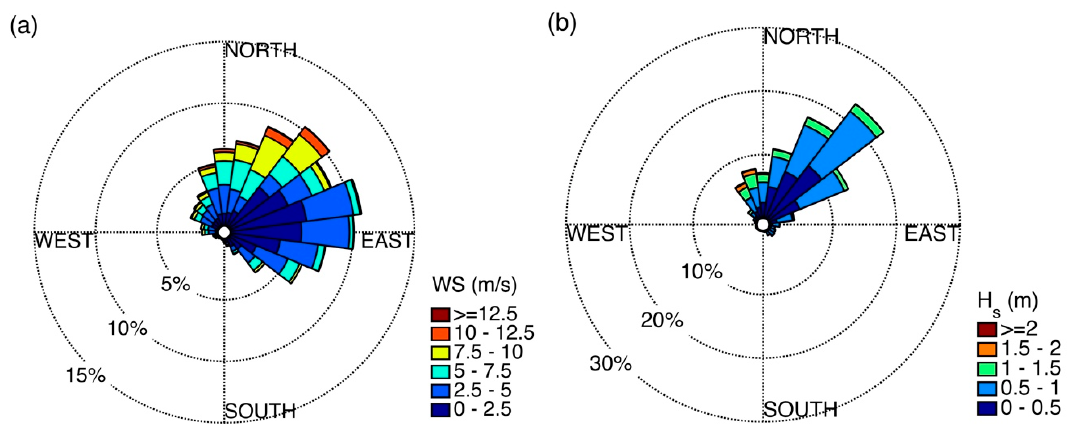
Figure 2. ( a ) Wind and ( b ) wave roses in the study area. Wind data are taken from the Sisal weather station MeteoSisal (www.weatherunderground.com 1 January 2009–17 June 2016) and the wave data were collected from an ADCP located at 10 m water depth in front of Sisal (10 December 2013–20